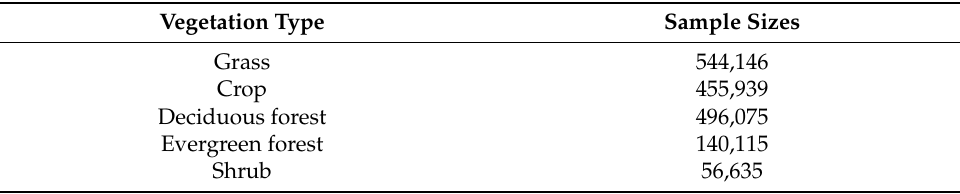
Table 1. Size of the sample set of each vegetation